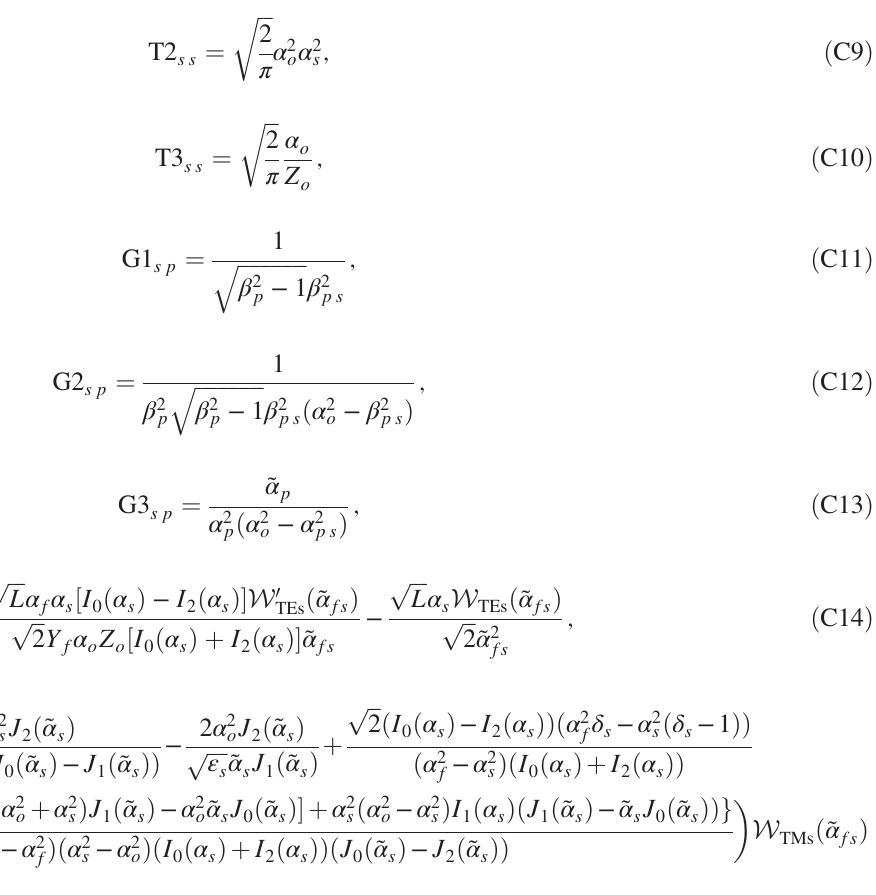
1 ffiffiffiffiffiffiffiffiffiffiffiffiffi